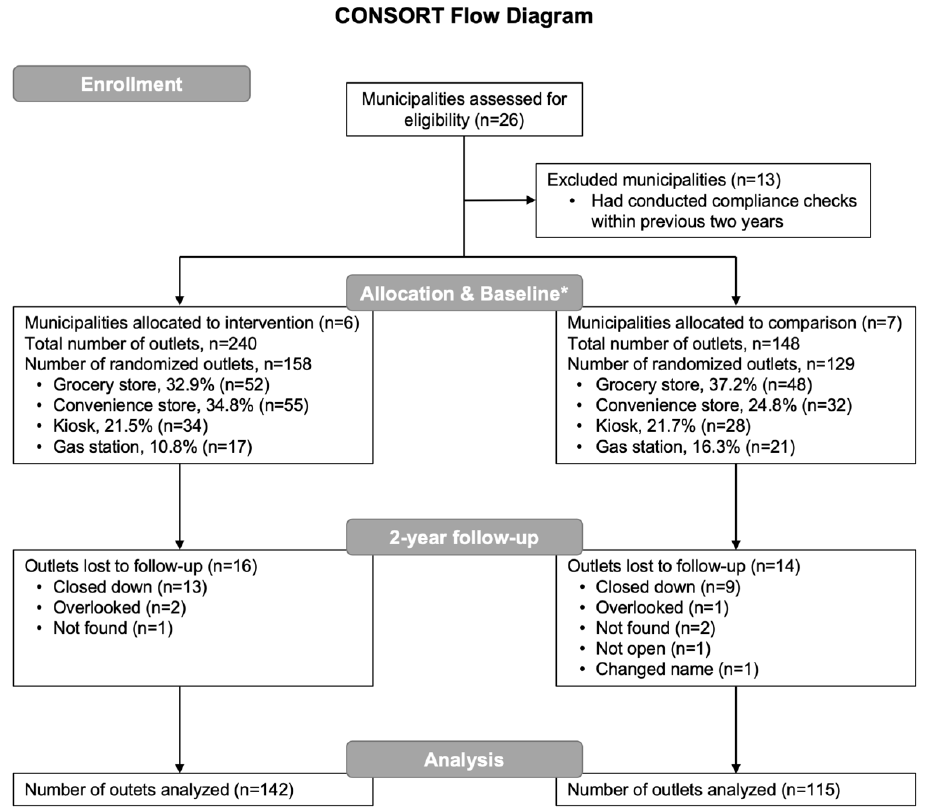
Figure 1. A flow diagram presenting the number of eligible and included municipalities as well as outlets at each assessment point. * A process evaluation conducted after the 2-year follow-up revealed that one municipality in the intervention group had not conducted the compliance checks intervention, while one municipality in the comparison group had conducted the intervention. These two municipalities hence changed group allocation. The final allocation of outlets is represented in the